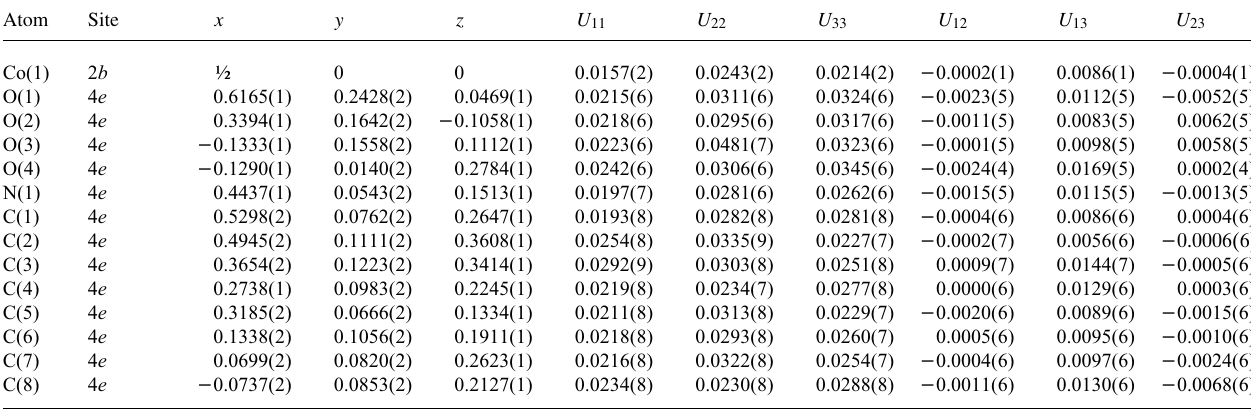
Table 3. Atomic coordinates and displacement parameters (in Å 2 )